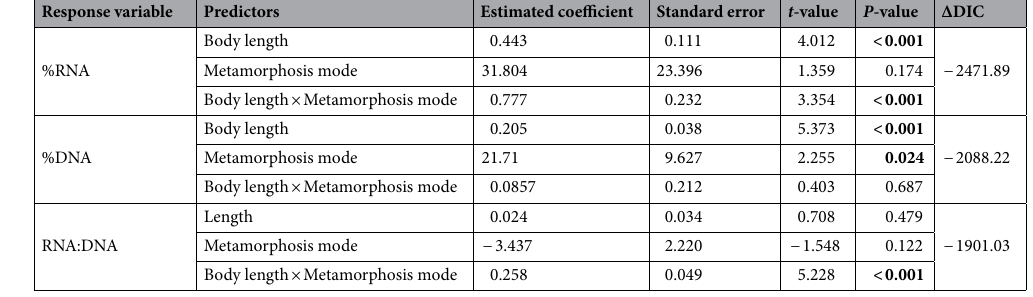
Table 2. Generalized linear mixed model results of body length, metamorphosis mode and the interaction between body length and metamorphosis mode as predictors of nucleic acid content (%RNA, %DNA and RNA:DNA) of aquatic macroinvertebrates with taxa nested within order set as random variables. ΔDIC: Difference between gamma model deviance information criteria minus DIC of the binomial model. Significant results ( P < 0.05) are indicated in